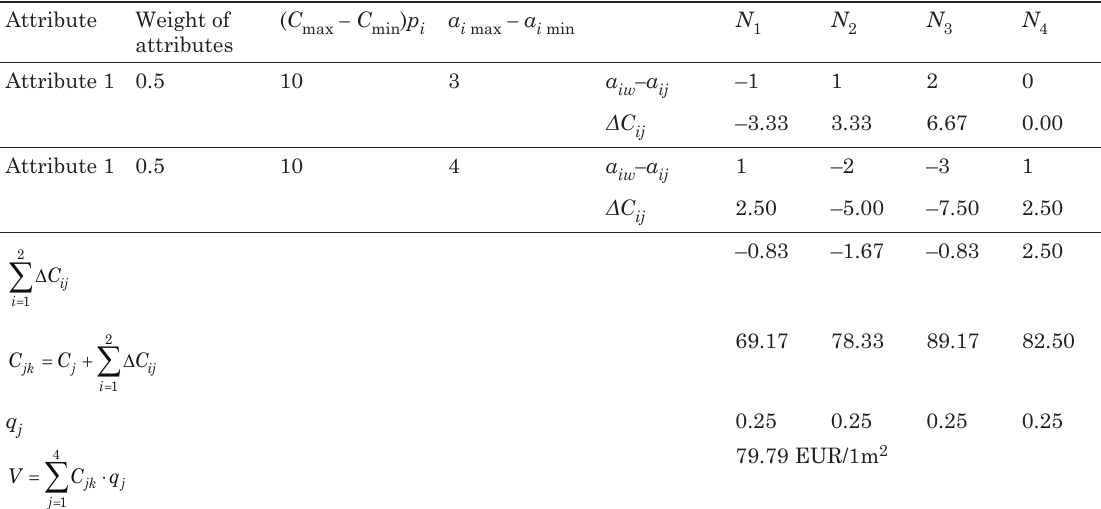
Table 2. Property valuation according to pairwise comparison method represented by formula (1–4)